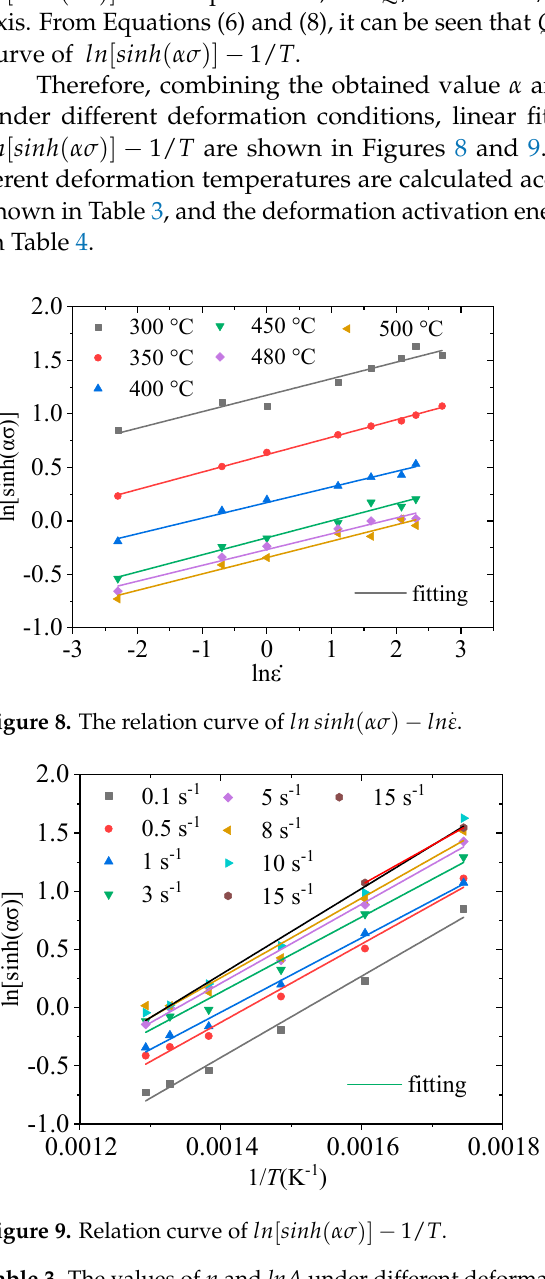
Figure 9. Relation curve of ln [ sinh ( ασ )] − 1/ T . Figure 9. Relation curve of 𝑙𝑛(cid:4670)𝑠𝑖𝑛ℎ(cid:4666)𝛼𝜎(cid:4667)(cid:4671) (cid:3398) 1 𝑇 ⁄ . Figure 9. Relation curve of 𝑙𝑛(cid:4670)𝑠𝑖𝑛ℎ(cid:4666)𝛼𝜎(cid:4667)(cid:4671) (cid:3398) 1 𝑇 ⁄ . Table 3. The values of n and lnA under different deformation Table 3. The values of n and lnA under different deformation conditions. Table 3. The values of n and lnA under different deformation conditions.